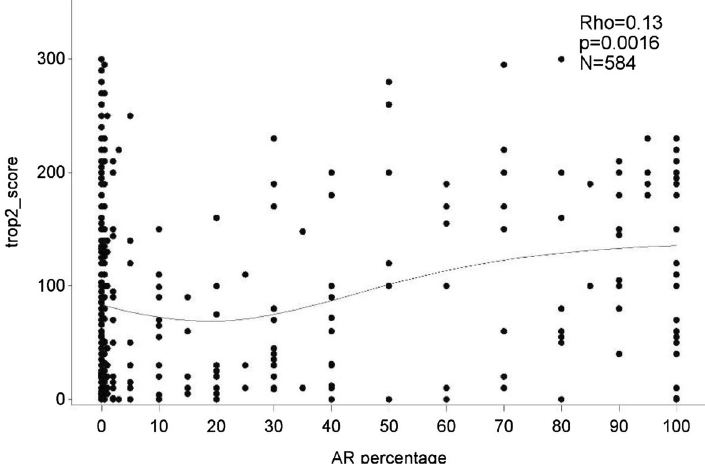
Figure 3. TROP-2 expression score was positively correlated with AR expression (10% cutoff). N = 584, ρ = 0.13, p = 0.002.